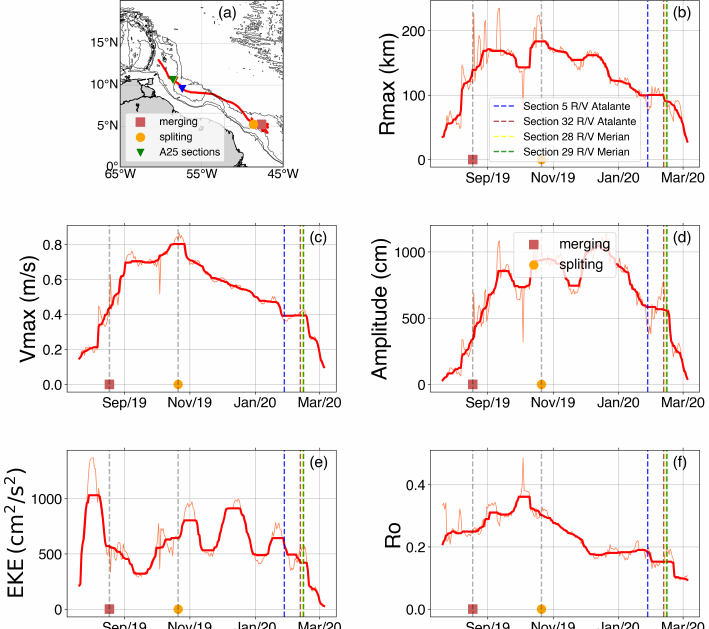
Figure 2. ( a ) Bathymetry map (from the ETOPO2 data set [52]) showing the trajectory of NBC Ring A2, positions of splitting and merging events, and intersections with the 4 sections performed during the EUREC 4 A-OA experiment. Evolution of A2 parameters is shown in the other panels : ( b ) Radius of maximum velocity, ( c ) Azimuthal velocity maximum, ( d ) Amplitude, ( e ) EKE, ( f ) Rossby number. The colored vertical bars indicate the date of the four sections performed by R/V L’Atalante and R/V Maria S